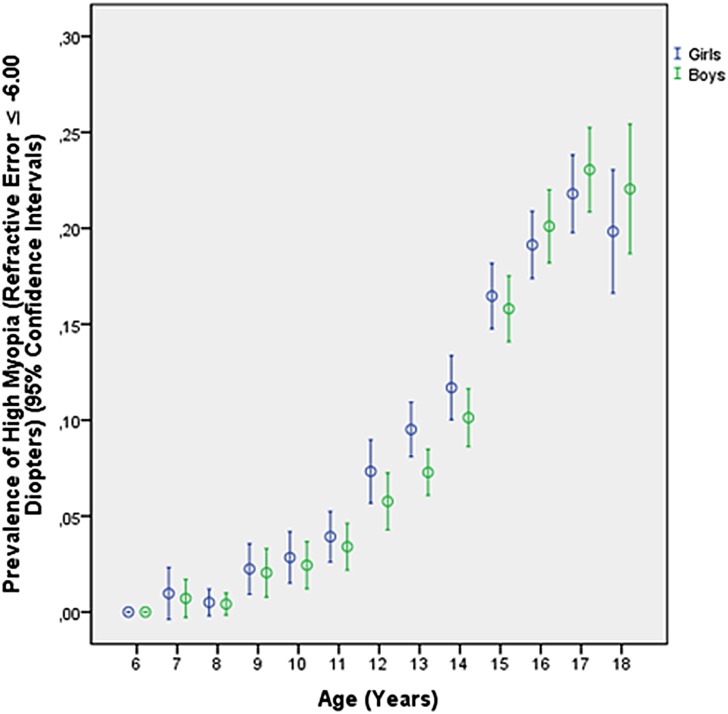
Diagram showing the prevalence of minor high myopia (myopic refractive error ≥-6.00 diopters) in the Greater Beijing School Children Myopia Study 2016.